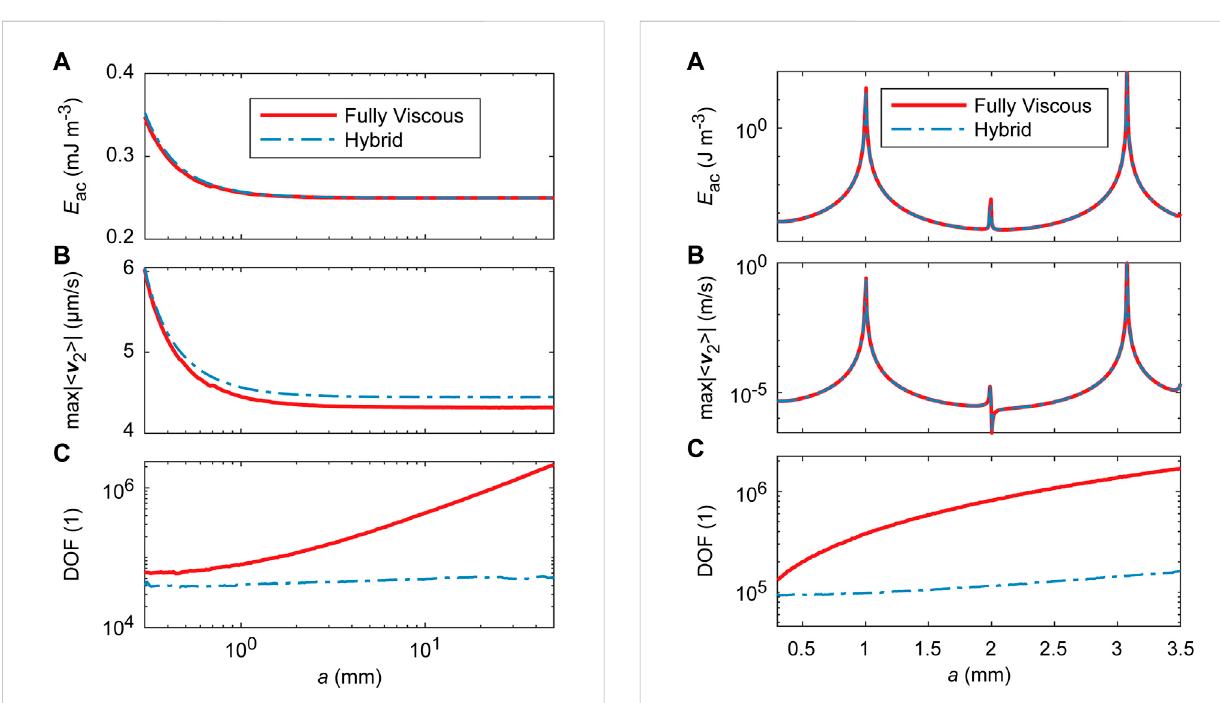
FIGURE 6 In fl uence of the channel width a on the performance of the Fully Viscous model and the Hybrid model for a subwavelength system with a sharp edge. The channel width is varied in the range of 0.3 mm ≤ a ≤ 50 mm at a fi xed low frequency of f = 10 kHz to avoid channel resonances. The channel contains a single sharp edge, as indicated in Figure 2, with h = 100 μ m, b = 150 μ m, α = 10 ° , and the sharp-edge rounding radius of 0.3 µm. (A) Average acoustic energy density E ac , (B) maximal Eulerian streaming velocity magnitude | 〈 v 2 〉 |, and (C) scaling of the DOF with the channel width. The excitation is imposed in the same direction (in phase) at x =± a /2, with a channel-width-dependent amplitude v a (cid:1) v [ 2 xf π / c ] that enforces a constant acoustic velocity mid cos 0 amplitude v mid = 1 mm s − 1 in the middle of the channel at the sharp edge.